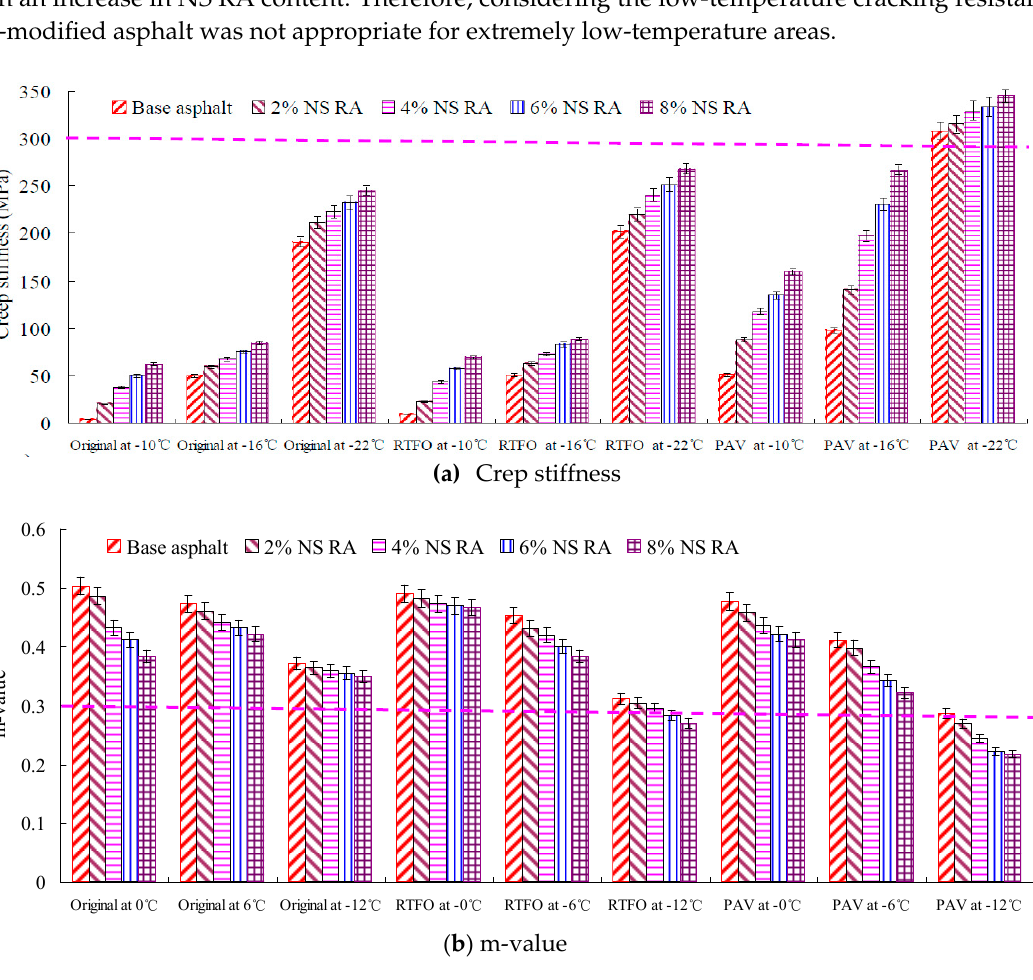
Figure 4. The bending beam rheometer test results of NS RA modified asphalt.